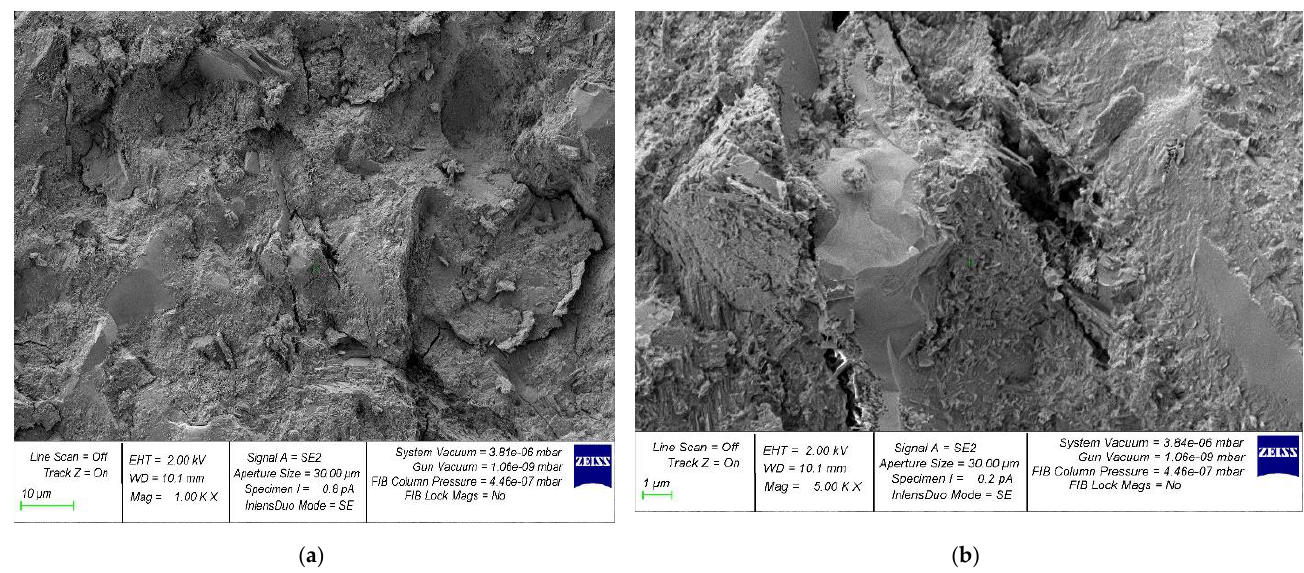
Figure 13. Samples containing 6% MSP: ( a ) 1000×; ( b ) 5000×.